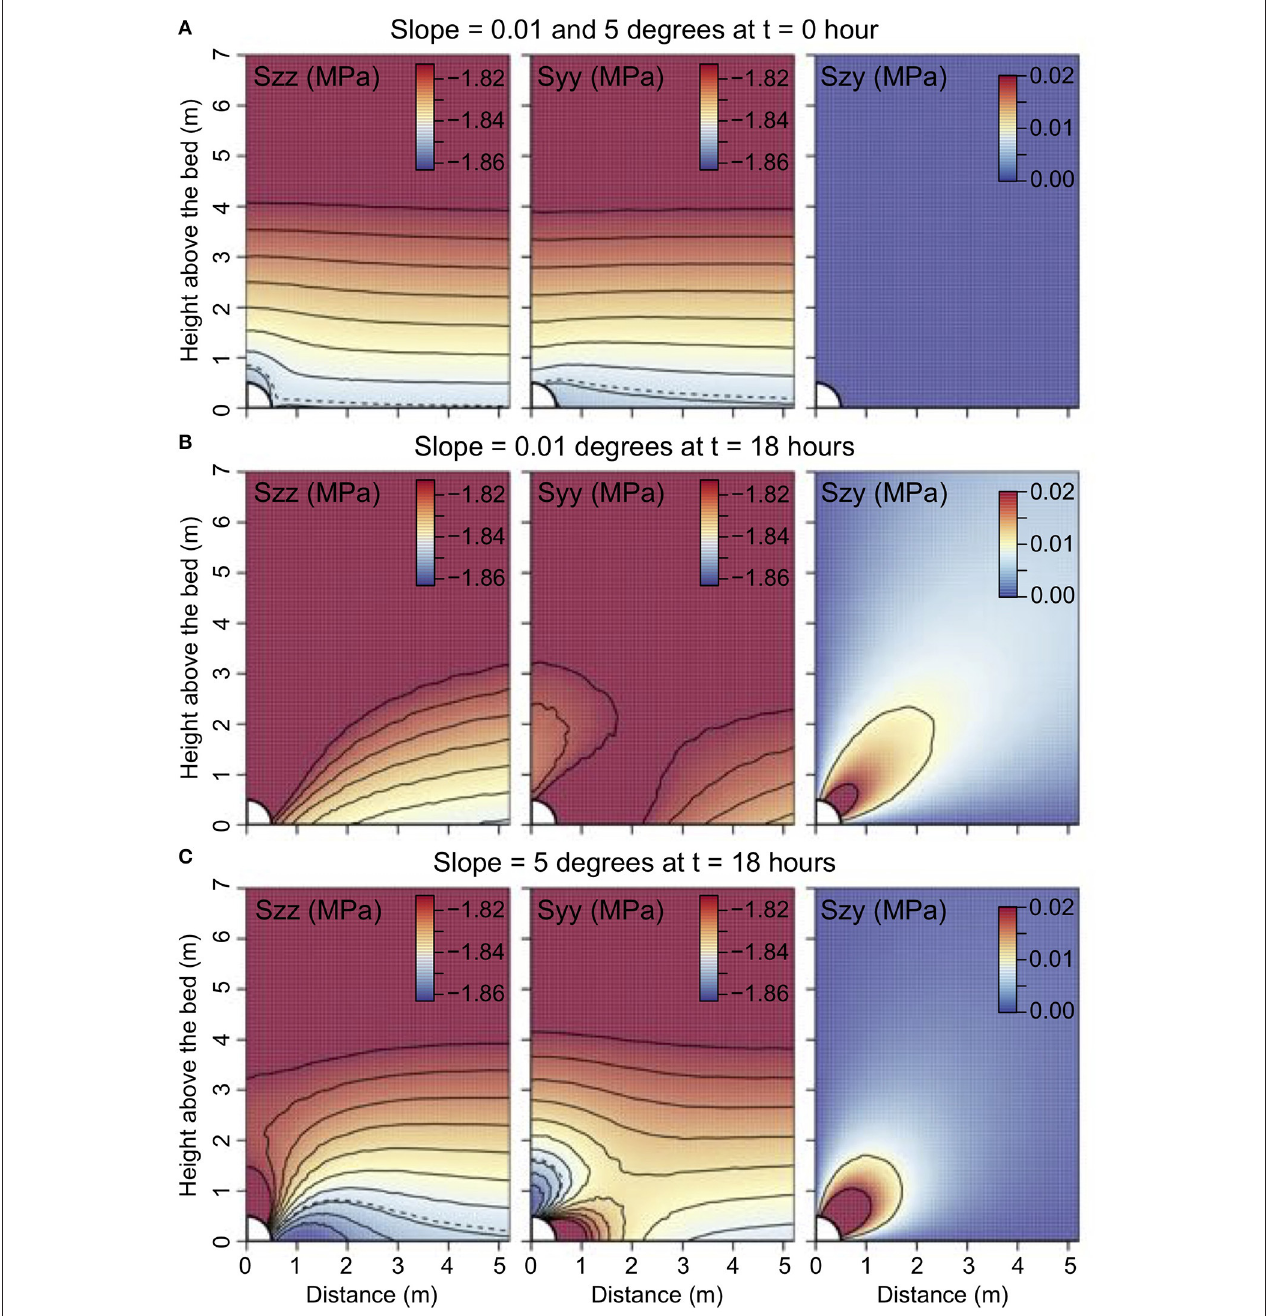
FIGURE 8 | Components of the stress tensor Szz, Syy, and Szy near the channel for the timesteps (A) t = 0 h and (B,C) t = 18 h and for slopes of (A,B) 0.01 degrees and (A,C) 5 degrees (domain width is 50 m). The water pressure approximates the overburden pressure at t = 0 and is at its lowest pressure at t = 18. The dashed contour line in the panels Szz and Syy shows where stresses are equal to the overburden pressure if there was no channel. The anti-correlation occurs close to the channel (C) , where the overburden contour lies above the bed. The figure covers only the first 7 m above and the first 5 m along the bed. The colour for the stresses is cut-off to highlight the variations at the